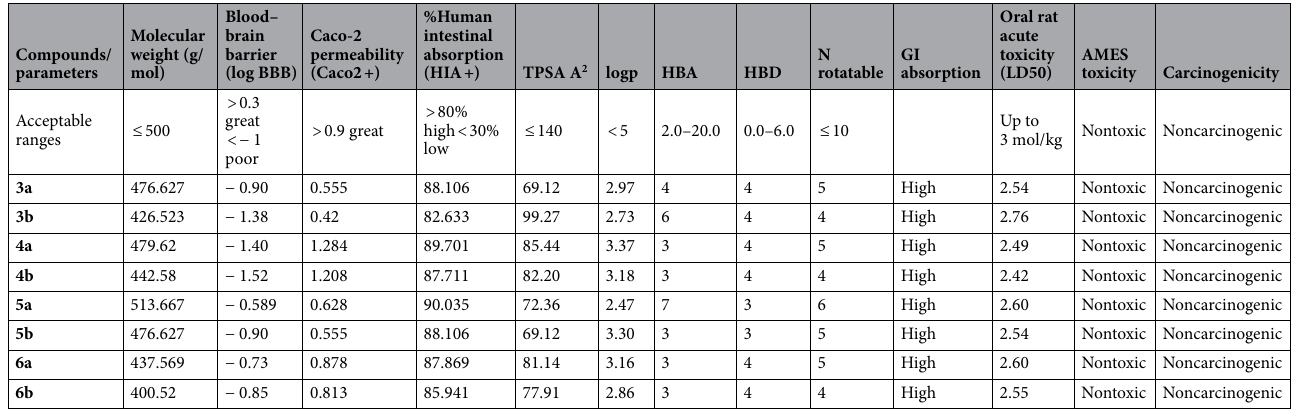
Table 4. ADMET and Pharmacokinetic properties of the compounds. TPSA: total polar surface area, GI: Gastrointestinal, BBB: Blood brain barrier, HBA: Hydrogen bond acceptor, HBD: Hydrogen bond donor, Logp: octanol/water partition coefficient.